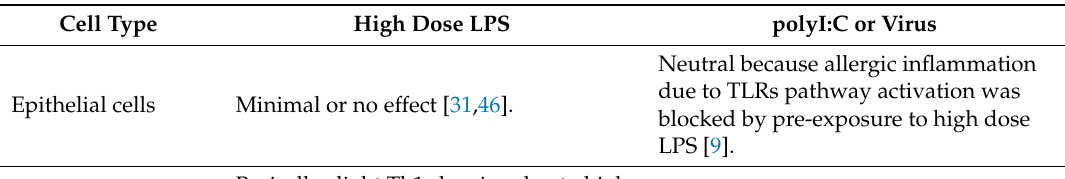
Table 4. Profile of four major players of the hygiene hypothesis model in the presence of high dose LPS before